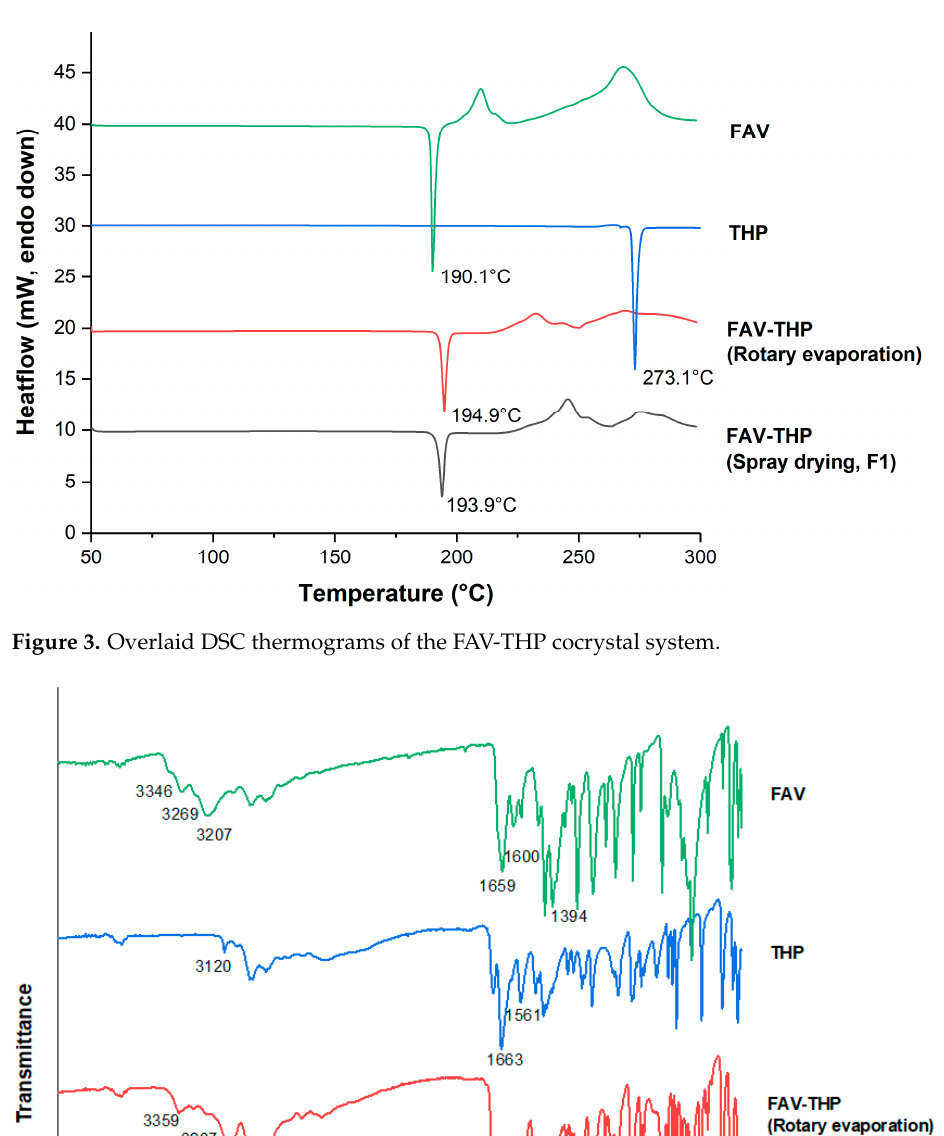
Table 3. Overview of the combinations of the material attribute and process parameters adopted.